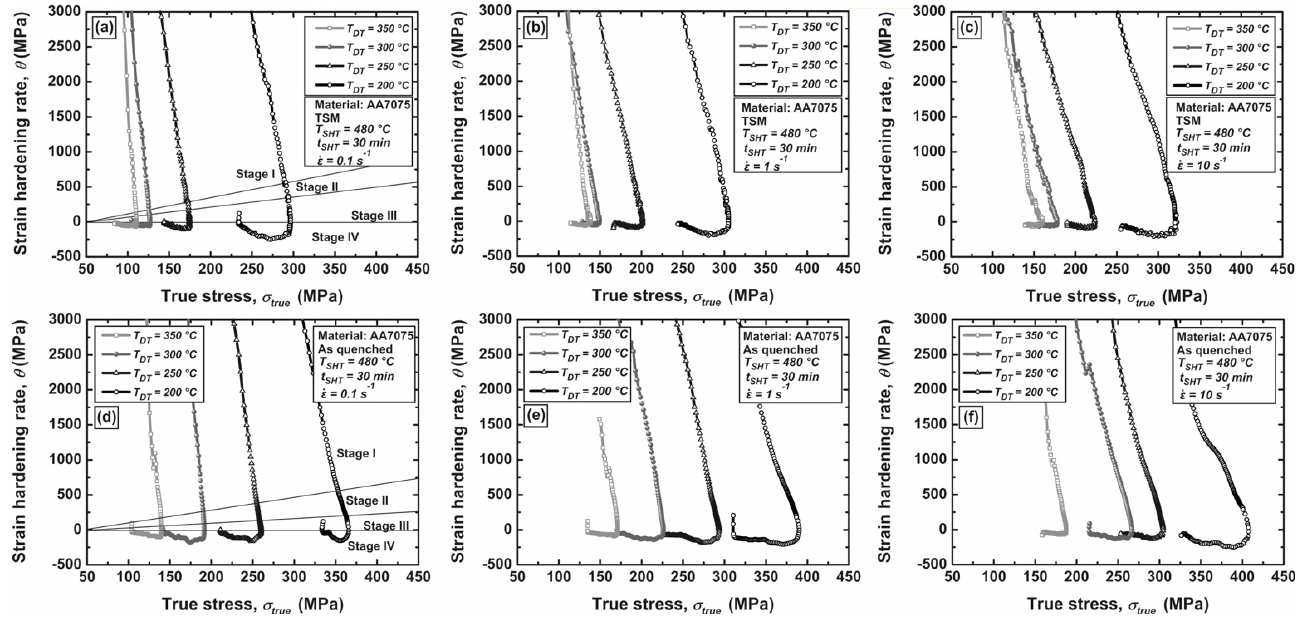
Figure 3. Strain ‐ hardening behavior of the investigated precipitation ‐ hardenable aluminum alloy Figure 3. Strain-hardening behavior of the investigated precipitation-hardenable aluminum alloy AA7075 at deformation temperatures ranging from T (cid:2888)(cid:2904) (cid:3404) 200 °C to T (cid:2888)(cid:2904) (cid:3404) 350 °C and strain rates AA7075 at deformation temperatures ranging from T DT = 200 ◦ C to T DT = 350 ◦ C and strain rates from ε(cid:4662) (cid:3404) 0.1 s (cid:2879)(cid:2869) to ε(cid:4662) (cid:3404) 10 s (cid:2879)(cid:2869) for ( a – c ) TSM and ( d – f ) for as ‐ quenched and conditions. . . ε = 0.1 s − 1 to ε = 10 s − 1 for ( a – c ) TSM and ( d – f ) for as-quenched and from